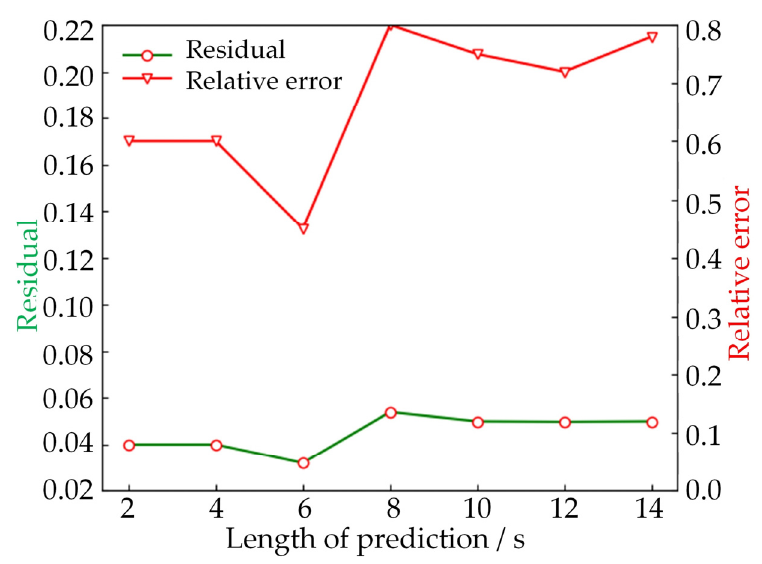
Figure 13. The residual and relative errors for different prediction lengths.